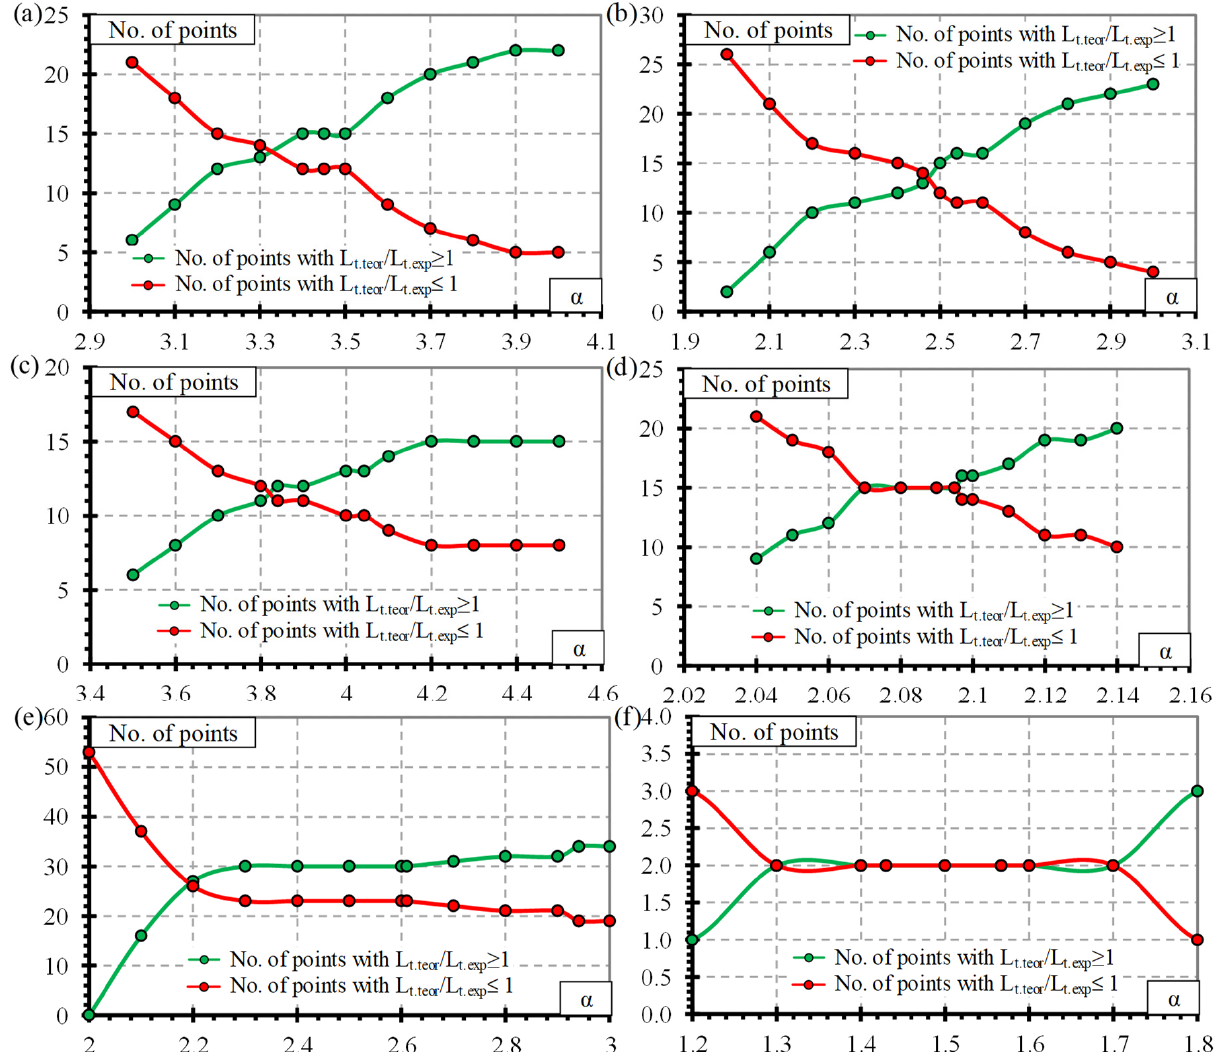
Figure 11. Comparison between the coefficient α and the number of experimental points of ( a ) CFCC strands, ( b ) CFRP bars, ( c ) AFRP Arapree bars, ( d ) AFRP Fibra and Technora bars, ( e ) all AFRP bars and ( f ) BFRP bars